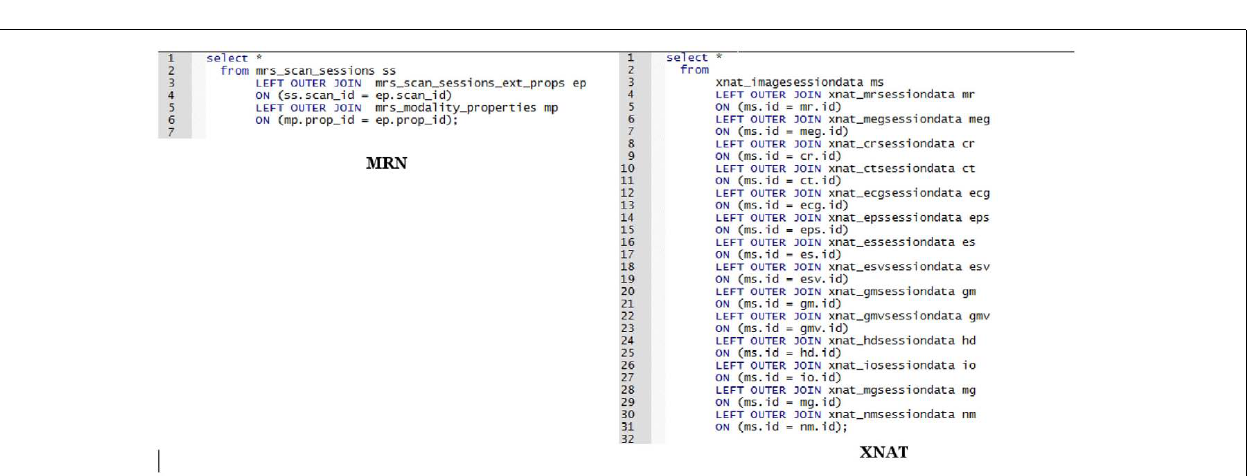
FIGURE 11 | SQL statements listing the study and subject with a “rest” task.